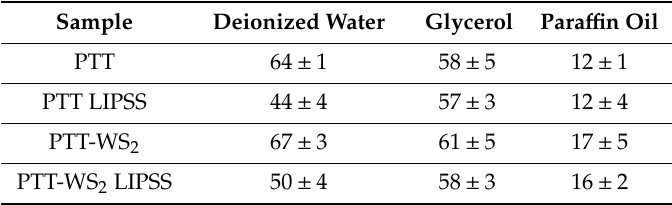
Table 2. Average contact angles measured by means of the sessile drop technique with deionized water, glycerol and para ffi n oil for non-irradiated samples and samples irradiated with 5000 pulses and a fluence of 20.3 mJ / cm 2 .